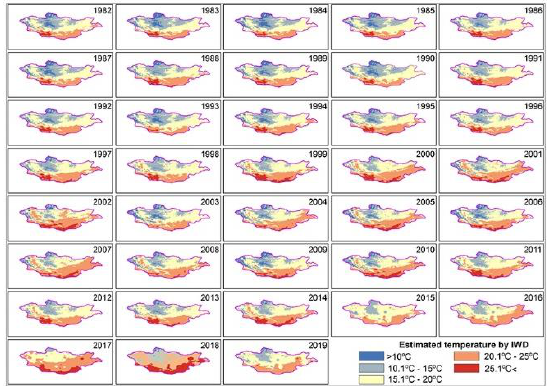
Figure 3. Spatial distribution map of summer air temperature estimated by IDW over Mongolia from 1982 to 2019.